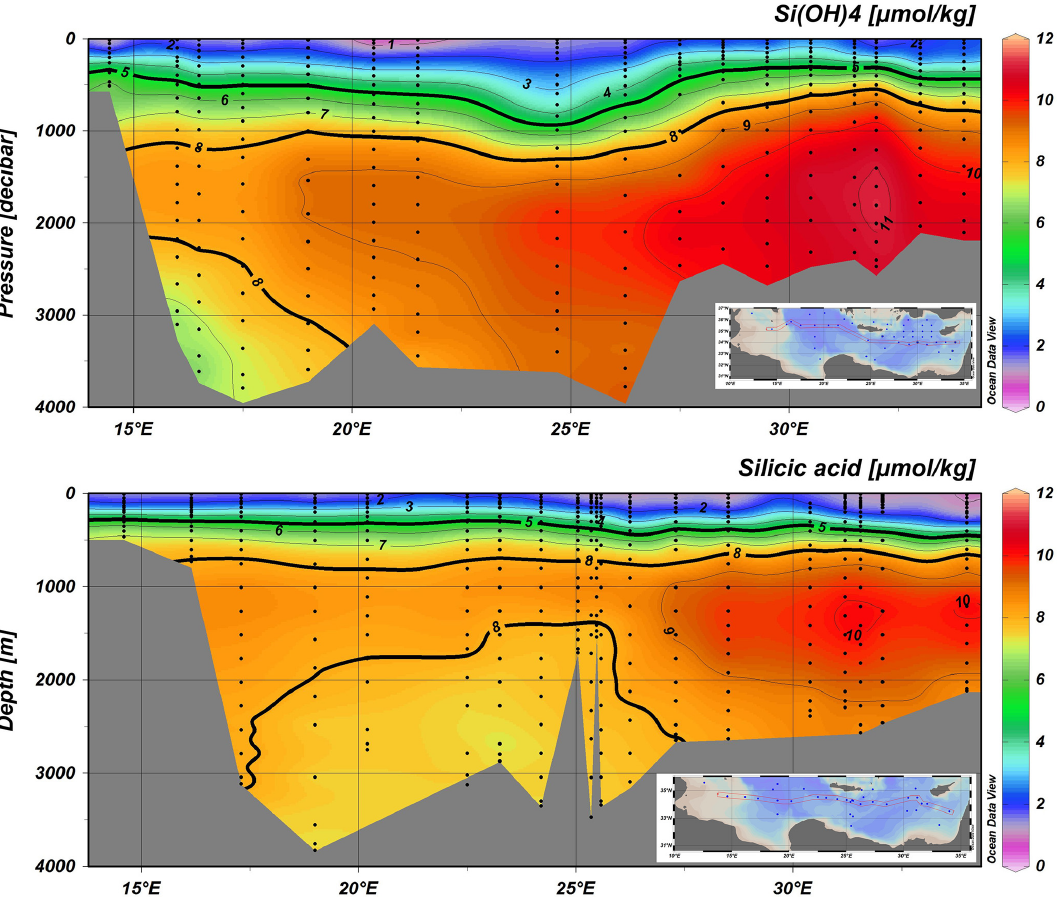
Figure 2. X section of silicic acid from the western Ionian Sea close to the location of Adriatic deep-water formation in the southern Adriatic to the eastern Levantine Sea. (a) X section measured in 1987 and showing the silicic acid distribution before the EMT increasing from 6.3µmolSikg − 1 in the western Ionian to 10.7µmolSikg − 1 in the eastern Levantine (Data from Schlitzer et al., 1991 and Nellen et al., 1996). (b) X section measured in 1999 after EMT event and showing the presence of newer deep water formed in the Aegean and advected into the deep water of the basin (Data from Kress et al.,